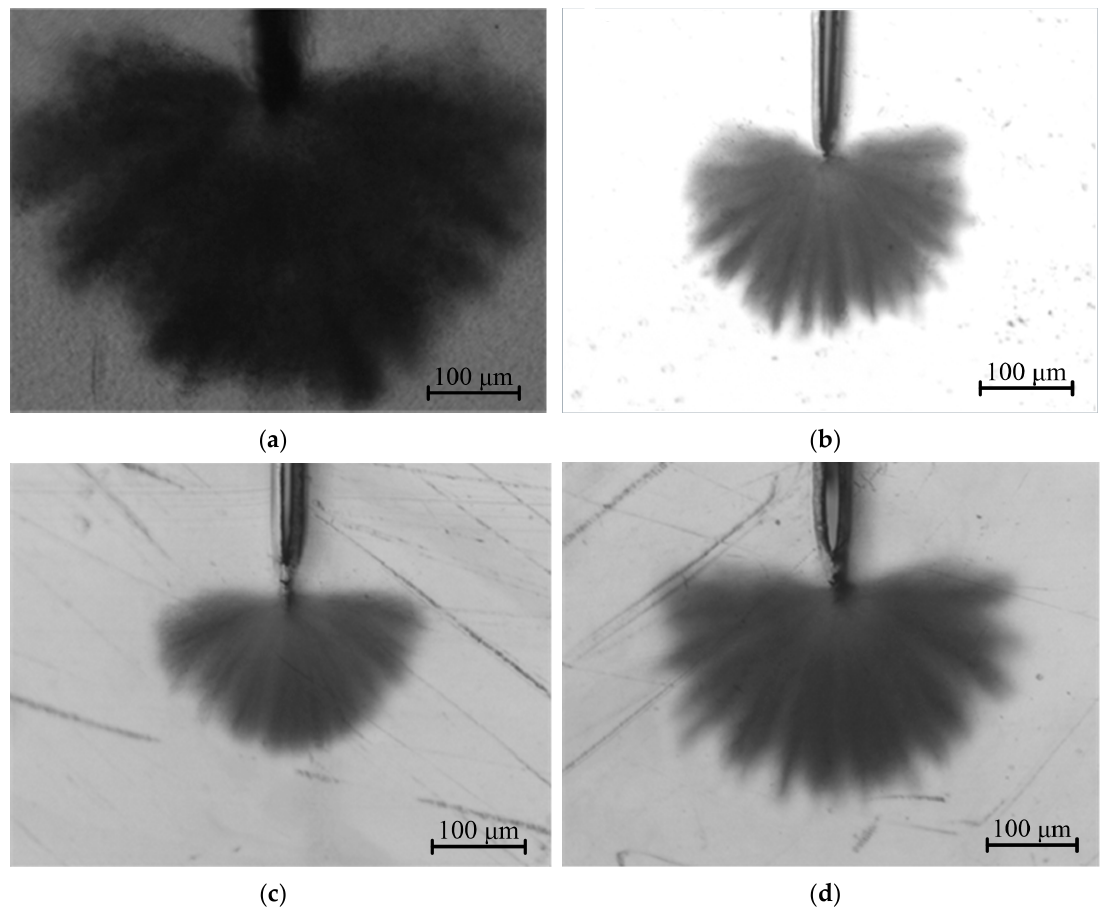
Figure 1. Water-tree morphology: ( a ) LLDPE, ( b ) XLPE-TMPTMA, ( c ) XLPE-TAIC, and ( d ) XLPE-HAV2.